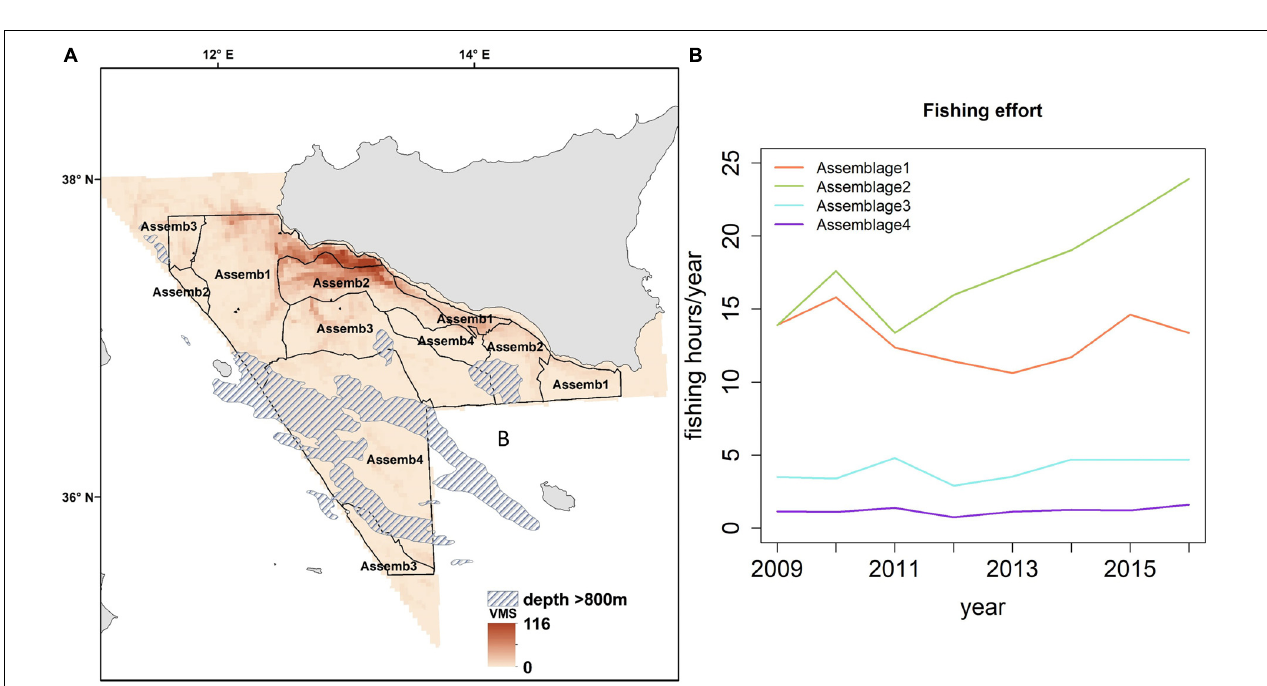
FIGURE 6 | Distance based redundancy analyses (dbRDA) of demersal community abundance and environmental variables based on Bray Curtis similarity. Vectors indicate direction of the parameter effect in the ordination plot. Significant environmental variables of sequential test are shown in blue ( p < 0.05).